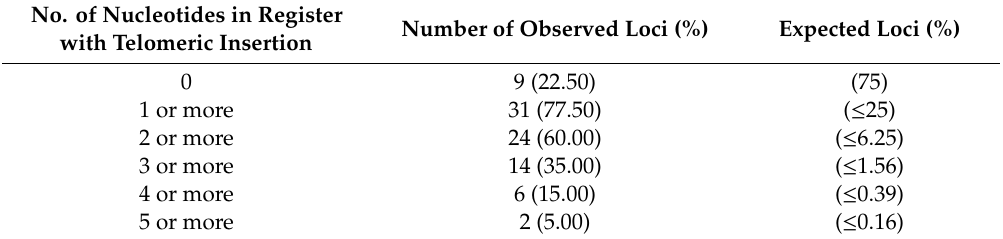
Table 6. Number of loci containing nucleotides in register with the telomeric